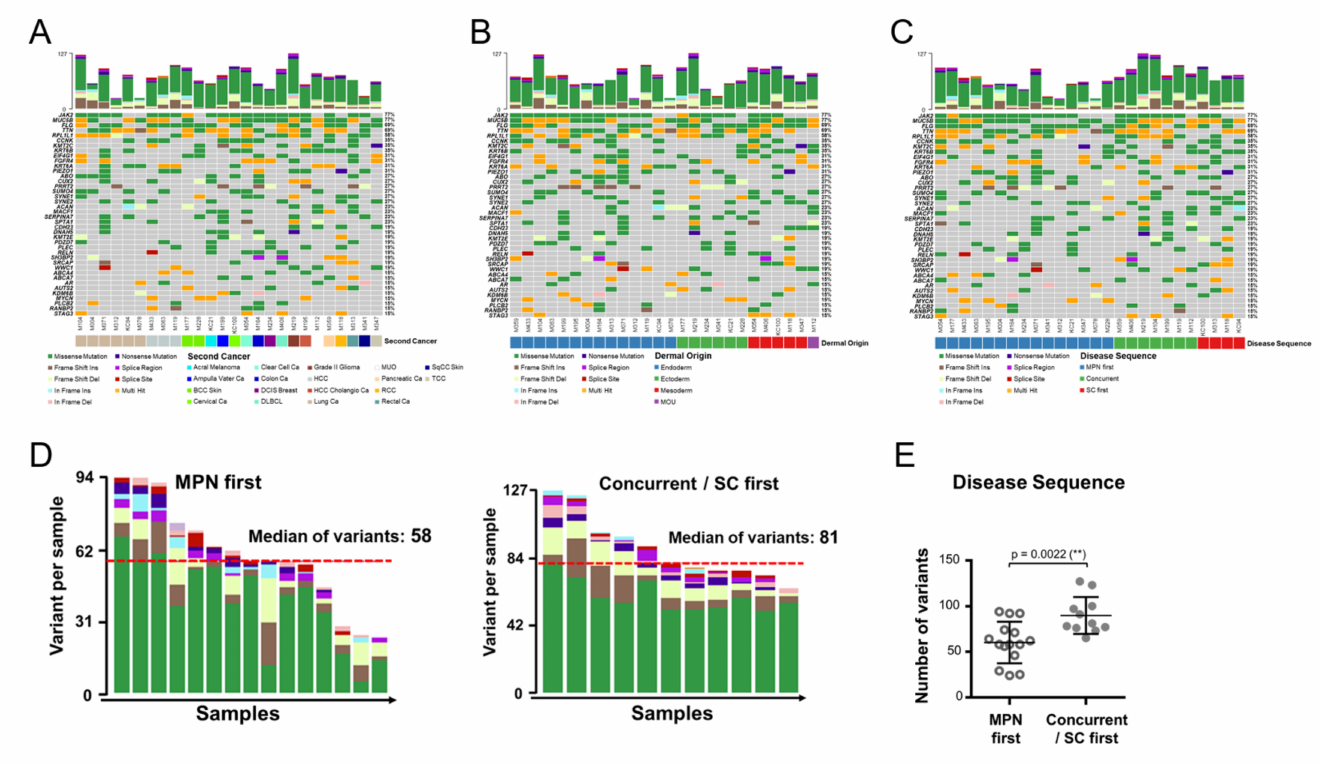
Figure 2. Comparisons on WES data of MPN patients with SCs. ( A – C ) Genes with variants in MPN with an SC stratified by cancer types ( A ), dermal origins ( B ), or disease sequence ( C ). Each stratification is represented by a corresponding color box shown at the bottom. ( D ) Subtypes and numbers of genomic variants stratified by the time sequence between the onset of MPN and SC. ( E ) Comparison of the numbers of variants based on disease sequence. **: p < 0.01, by Student’s t